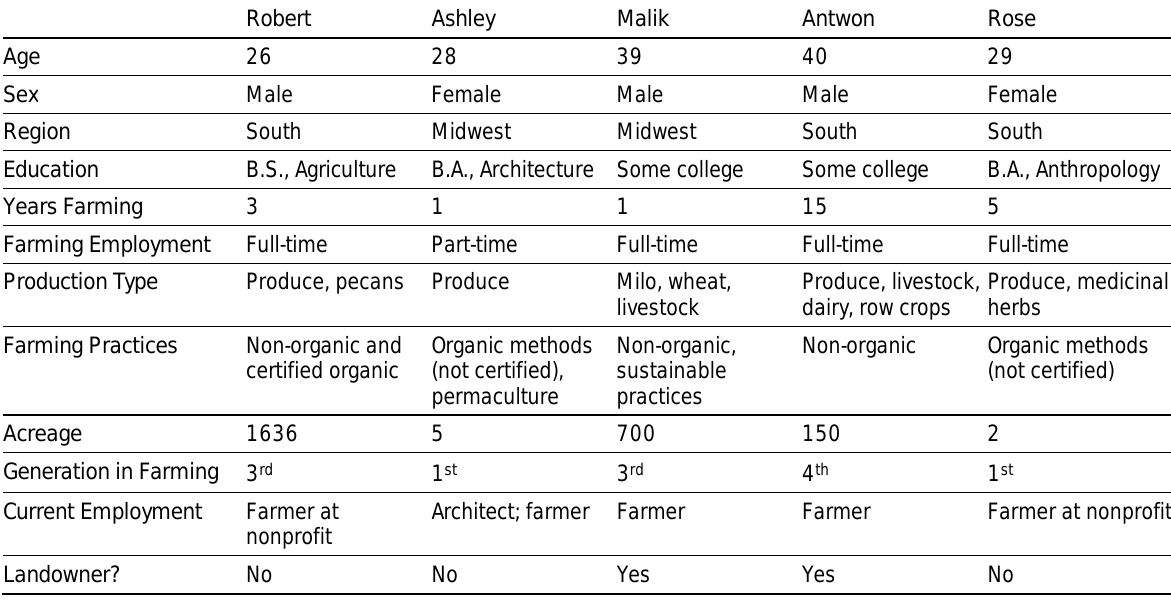
Table 1. Demographics of Participant